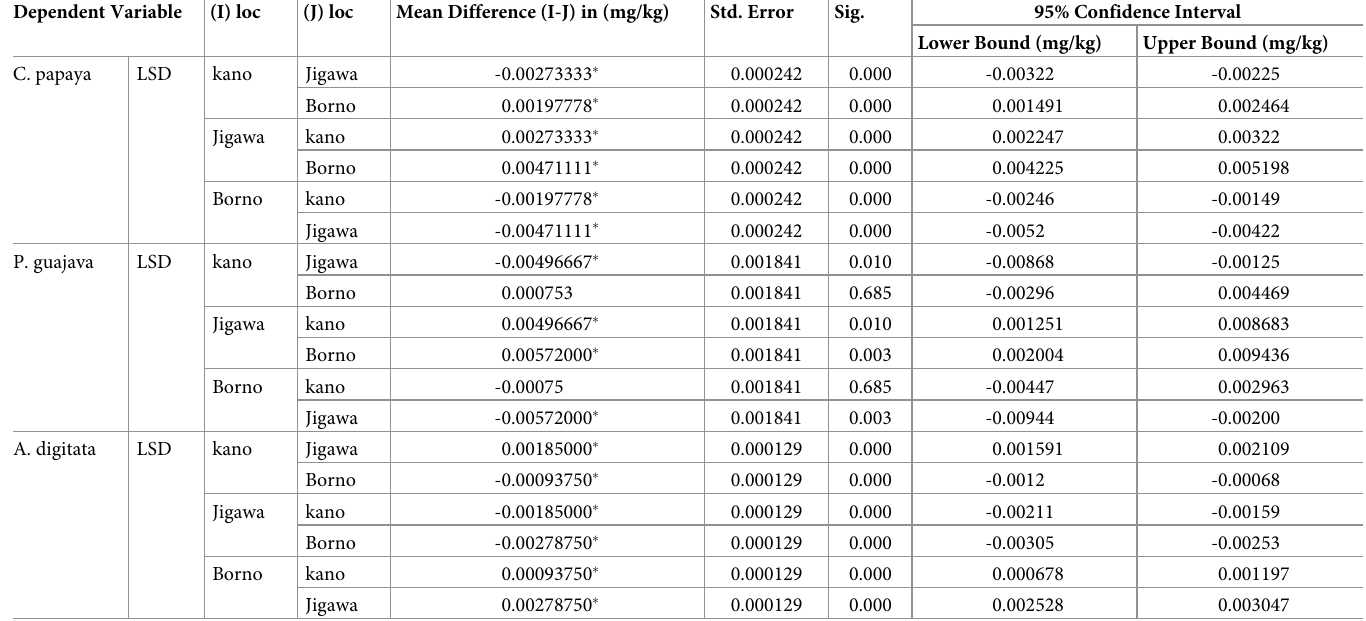
Table 6. Multiple comparisons for